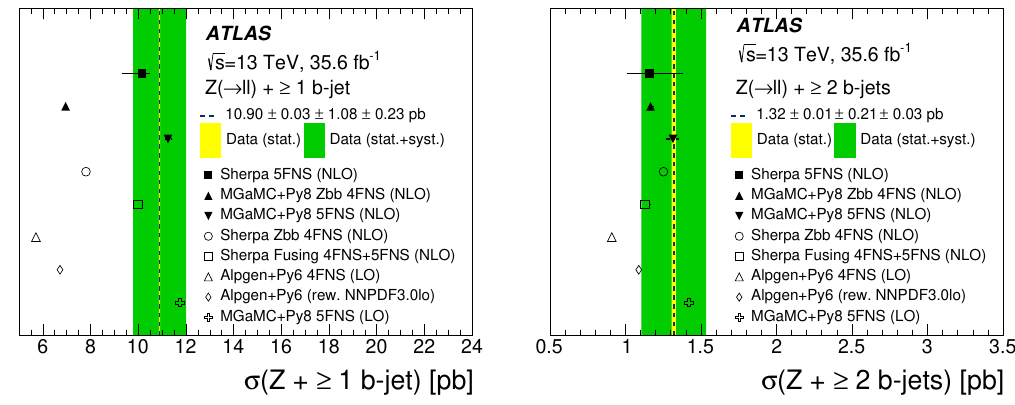
Figure 7 . Measured cross-sections for Z + (cid:21) 1 b -jet (left) and Z + (cid:21) 2 b -jets (right). The data are compared with the predictions from Sherpa 5FNS (NLO) , Alpgen + Py6 4 FNS (LO) , Sherpa Fusing 4FNS+5FNS (NLO) , Sherpa Zbb 4FNS (NLO) , MGaMC + Py8 5FNS (LO) , MGaMC + Py8 Zbb 4FNS (NLO) and MGaMC + Py8 5FNS (NLO) . The yellow band corresponds to the statistical uncertainty of the data, and the green band to statistical and systematic uncertainties of the data, added in quadrature. The error bars on the Sherpa 5FNS (NLO) predictions correspond to the statistical and theoretical uncertainties added in quadrature. Only statistical uncertainties are shown for the other